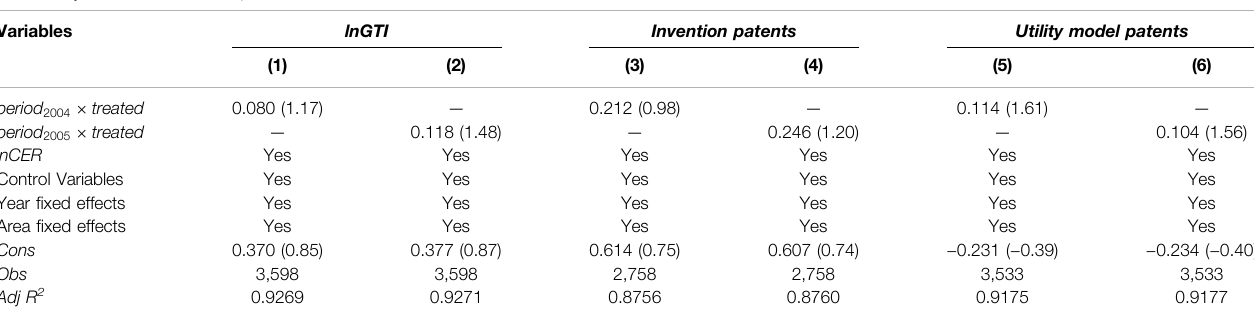
TABLE 8 | Estimation results of placebo